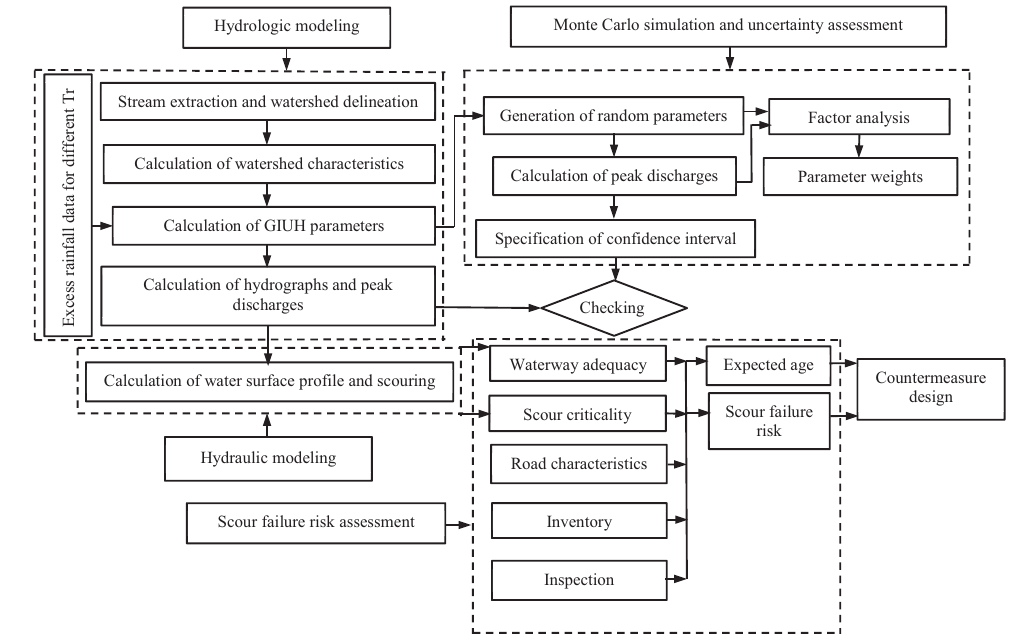
Figure 1. Flowchart of the methodology to assess the scour failure risk of the Çatalzeytin